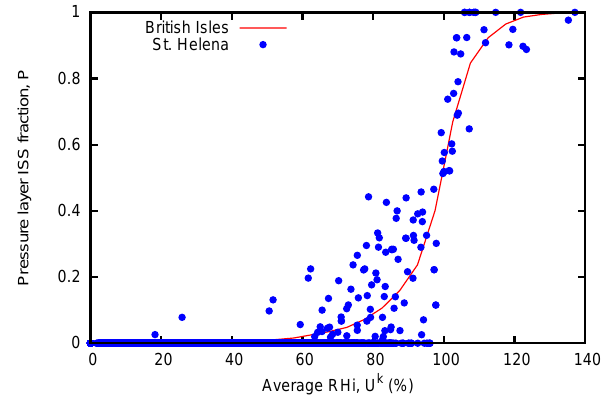
Fig. 12. The relationship between average RHi and the ISS fraction within 50hPa pressure layers, comparing data from St. Helena to the British Isles mean is shown. The s-shaped relationship for St. Helena is not shown because the ISS fraction is too low ( ∼ 2 . 1%). These data are derived from six high resolution radiosonde launch stations within the British Isles and one from St. Helena (January 2002–December 2006).